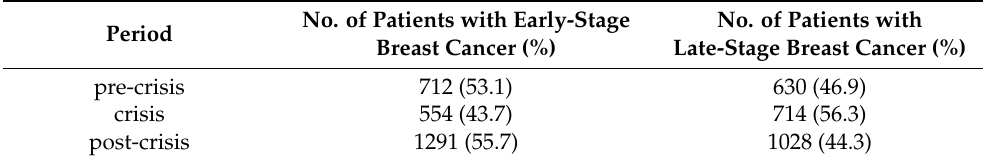
Table 2. Distribution of study group by the moment of diagnosis.